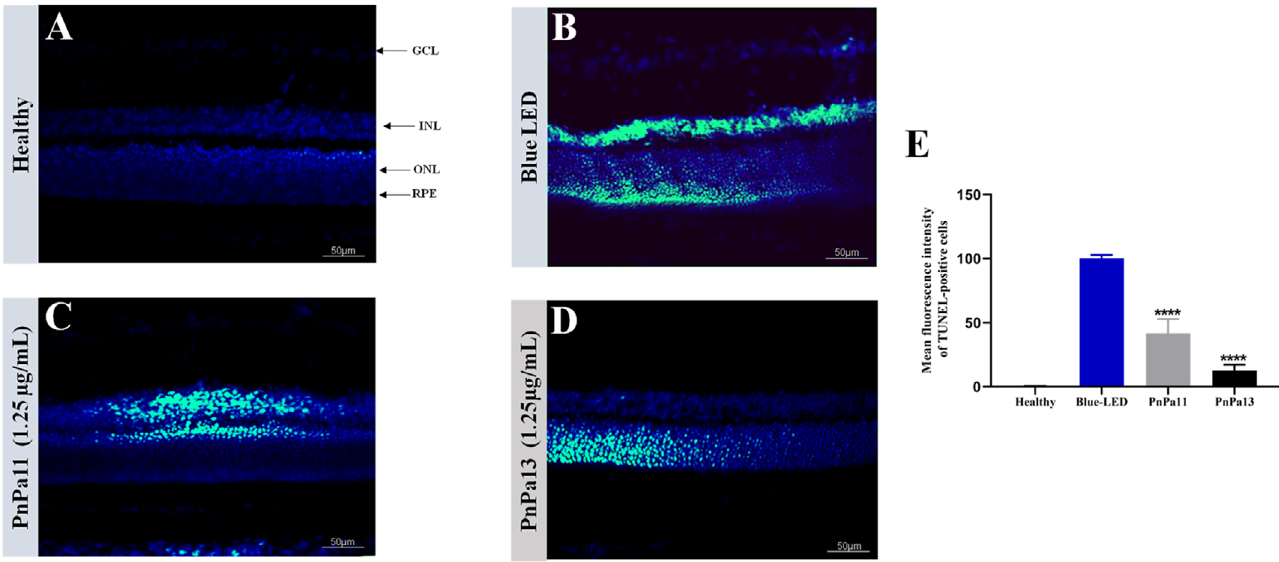
Figure 7. Evaluation of apoptotic cell death in blue LED retinal degeneration by TUNEL staining. Confocal micrographs were taken from vertical of sections of (A) healthy retina, (B) 2000-lux blue LED-exposed retinas, (C) PnPa11 (1.25 µg/mL) before blue LED light exposure and, (D) PnPa13 (1.25 µg/mL) before blue LED light exposure for (E) TUNEL staining are shown. Retinal layers were stained with DAPI (in blue) and TUNEL-positive cells are represented as green spots. Blue LED was set as 100% and mean ± SD treated with PnPa11 (1.25 µg/mL) or PnPa13 (1.25 µg/mL) before blue LED light exposure using one-way ANOVA followed by Tukey post-test. Three measures per slide were performed (n = 3). *Significant difference as compared to healthy group (****p < 0.0001). Scale bar = 50